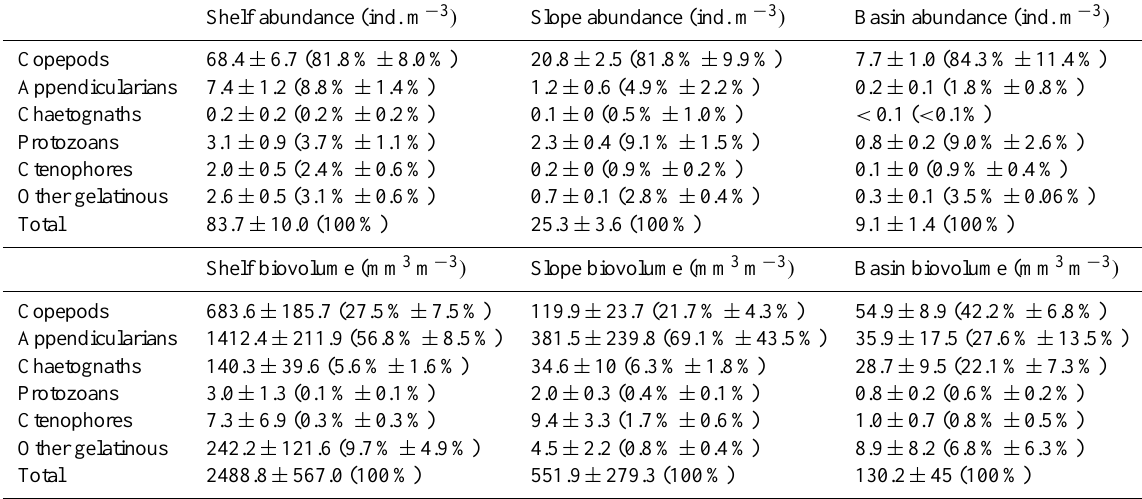
Table 2. Abundance and biovolume of zooplankton groups (mean ± SE and percent contribution in brackets) as identified and measured using an Underwater Vision Profiler 5 (UVP5) connected to a CTD-rosette profiler and deployed in the shelf ( < 100m), slope (100–1000m) and basin ( > 1000m) regions of southeast Beaufort Sea in July–August 2009 (Fig. 1). The data presented in this table summarize the entire UVP5 dataset comprising 154 profiles (Appendix A). The vertical distribution of each zooplankton group abundance and biovolume is presented in Fig.